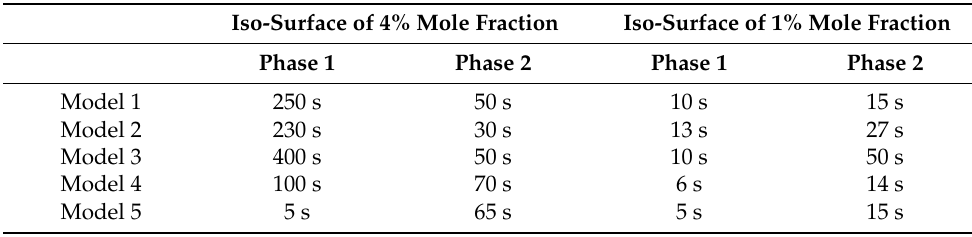
Table 3. The time for iso-surfaces of 4% and 1% mole fraction of the hydrogen diffusion process for Model 1–Model